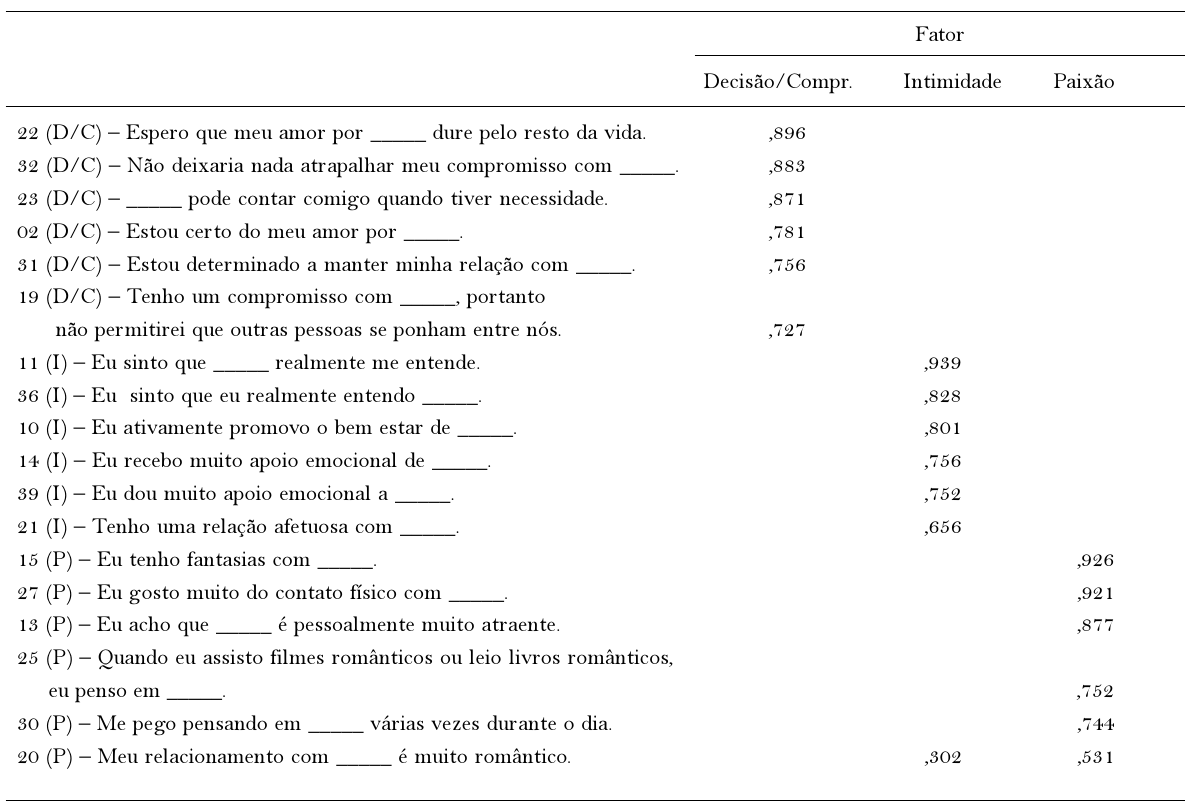
Análise Fatorial da Versão Brasileira Reduzida da Escala Triangular do Amor de Sternberg